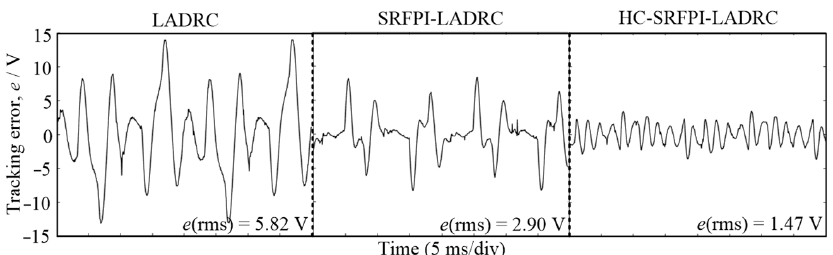
Figure 18. Voltage tracking error of different control strategies under nonlinear load.